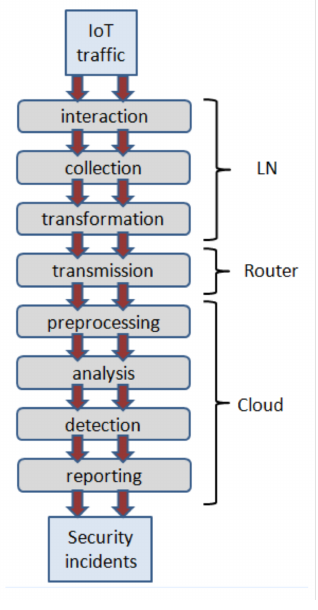
Figure 2. Functional system